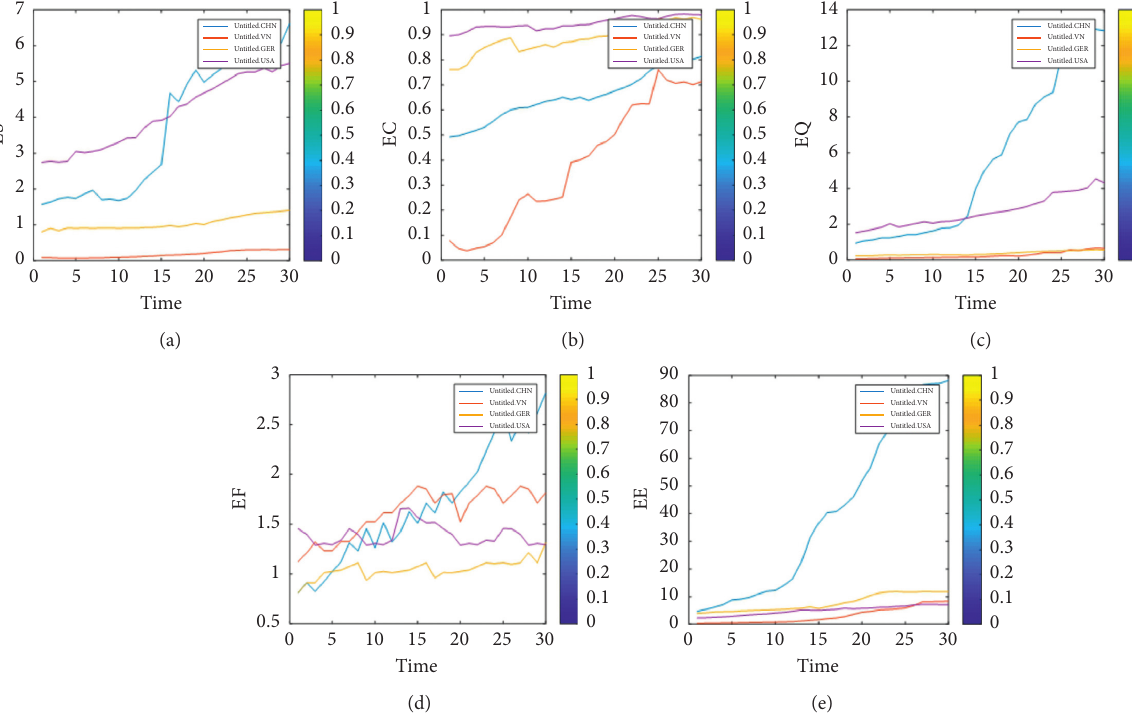
Figure 5: Comparison of scores of five indicators in different